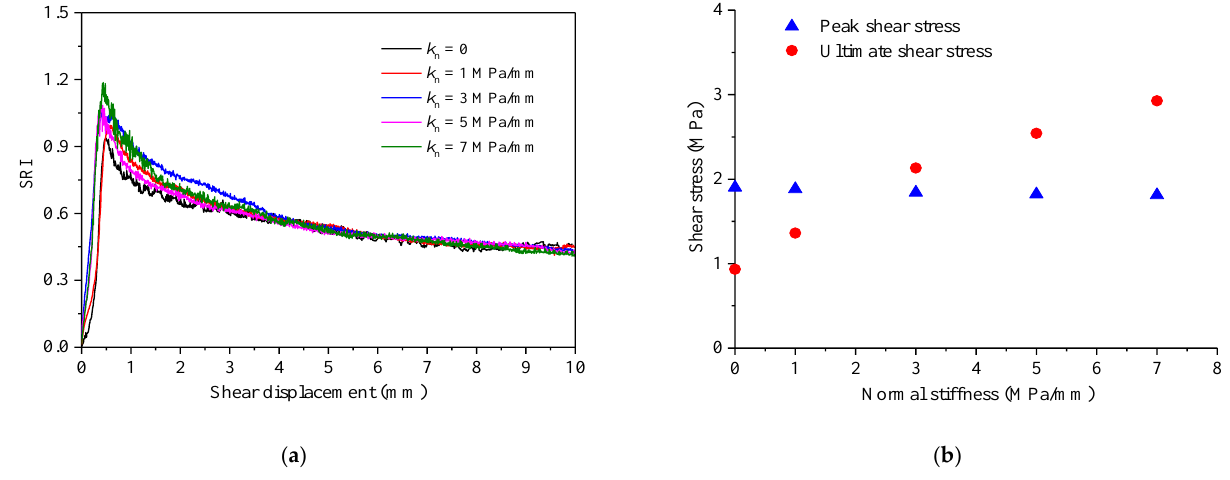
Figure 5. The relationship between normal stiffness and SRI and shear strength of joints. ( a ) Relation between SRI and shear displacement of the structural plane. ( b ) Variation of peak and ultimate shear stress for joints under different normal stiffness